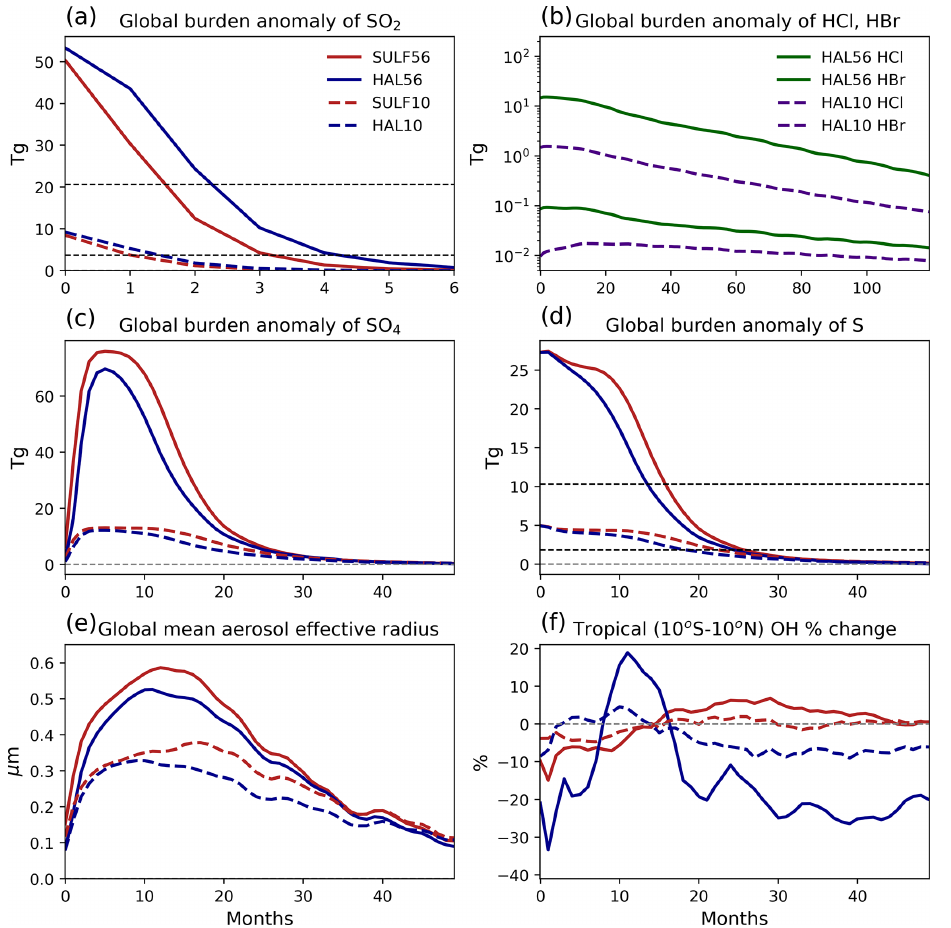
Figure 1. Evolution of sulfur, halogens, aerosol effective radius, and OH for the SULF10, HAL10, SULF56, and HAL56 simulations relative to the control climatology. (a) Global SO 2 burden anomalies. (b) Global HCl and HBr burden anomalies on a log scale. (c) Global sulfate aerosol burden anomalies. (d) Global total sulfur burden anomalies. (e) Global-mean aerosol effective radius, weighted by aerosol surface area density. (f) Tropical (10 ◦ N–10 ◦ S) stratospheric OH change (%). Dashed horizontal lines in panels (a) , (b) , and (d) represent the mass remaining after one e -folding time. Note the different axis